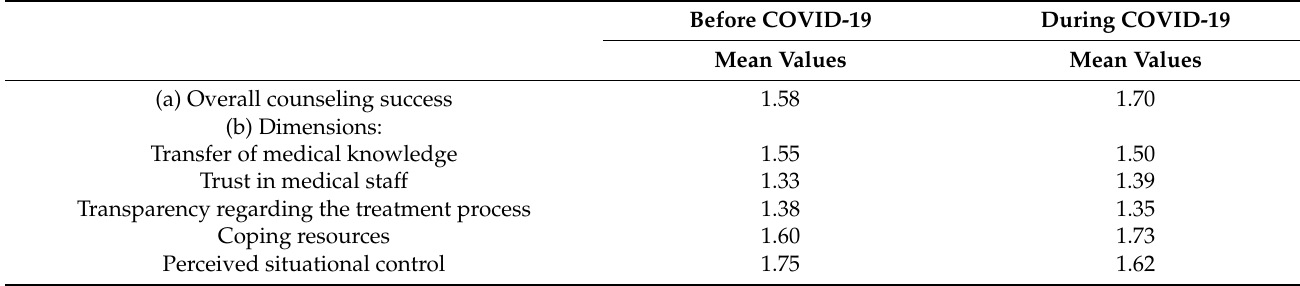
Table 4. Mean values for parental counseling success—overall (a) and in the five analytical dimensions (b)—if complex fetal CHD was diagnosed: before and during the COVID-19 pandemic (1 = successful to 3 = unsuccessful). Before COVID-19 During COVID-19 Mean Values Mean Values